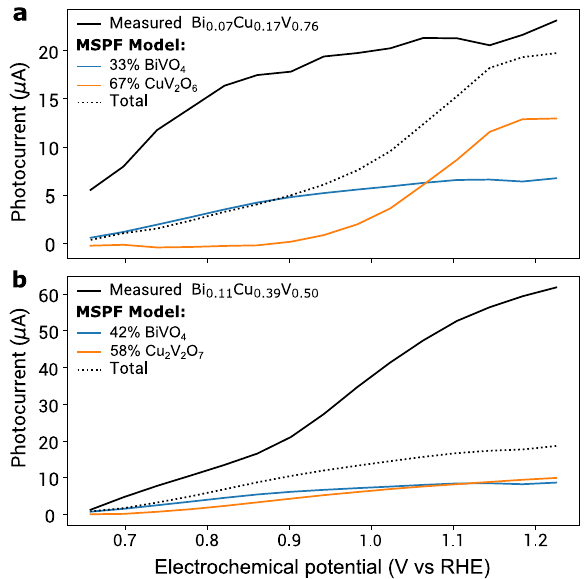
Fig. 4 The measured photoactivity and its corresponding prop- erty factorization model for the maximum-residual compositions in two composition regions shown in Fig. 3. a The Bi 0.07 Cu 0.17 V 0.76 photoanode composed of 33% BiVO 4 and 67% CuV 2 O 6 ; b The Bi 0.11 Cu 0.39 V 0.50 photoanode composed of 42% BiVO 4 and 58% Cu 2 V 2 O 7 . Note that these phase concentrations are labeled by prototype formula unit, although the composition within each phase may be different due to